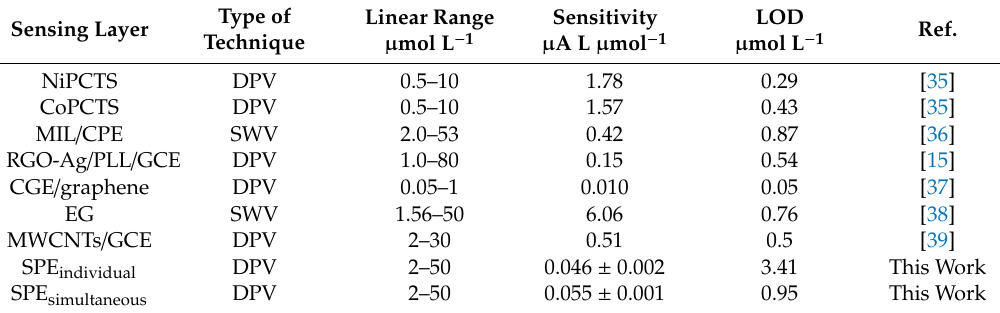
Table 1. Electrode materials for the detection of